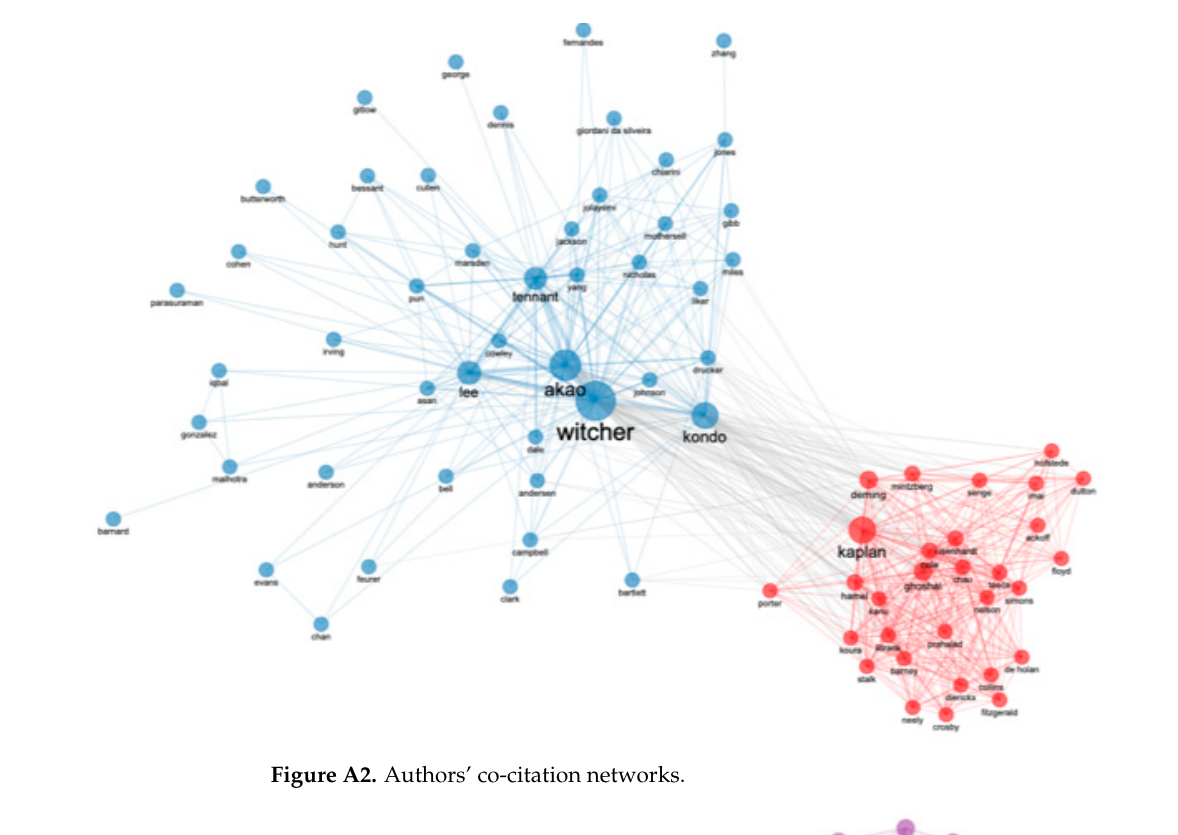
Processes 2022 , 10 , 1854 Figure A2. Authors’ co-citation networks. Figure A2. Authors’ co-citation networks.